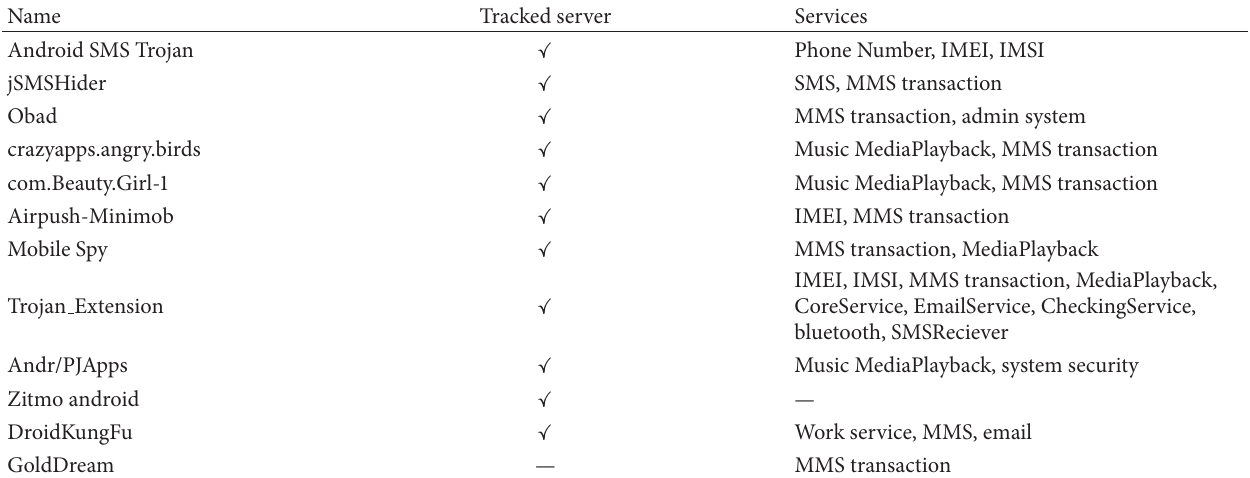
Table 7: Tracking result.